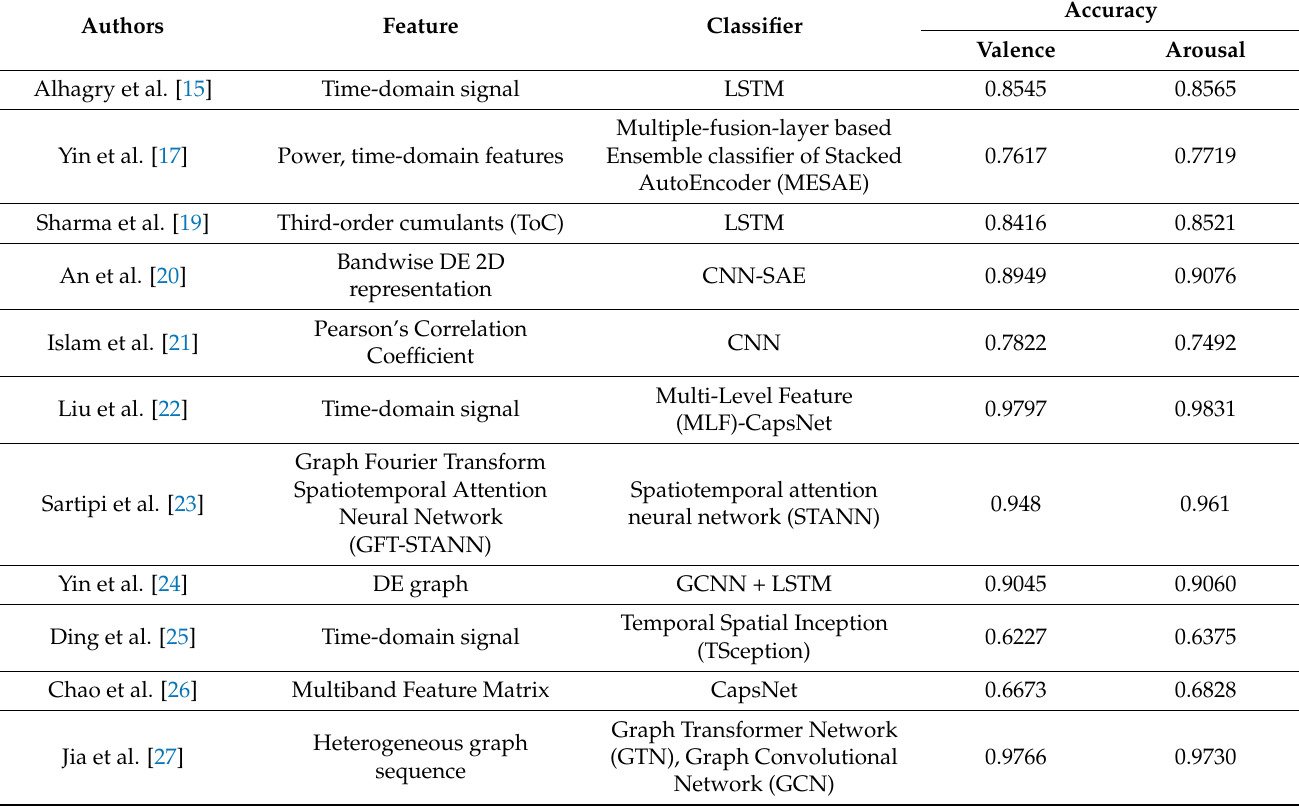
Table 4. Performance comparison of the state-of-the-art models in the binary classification of valence and arousal on the DEAP